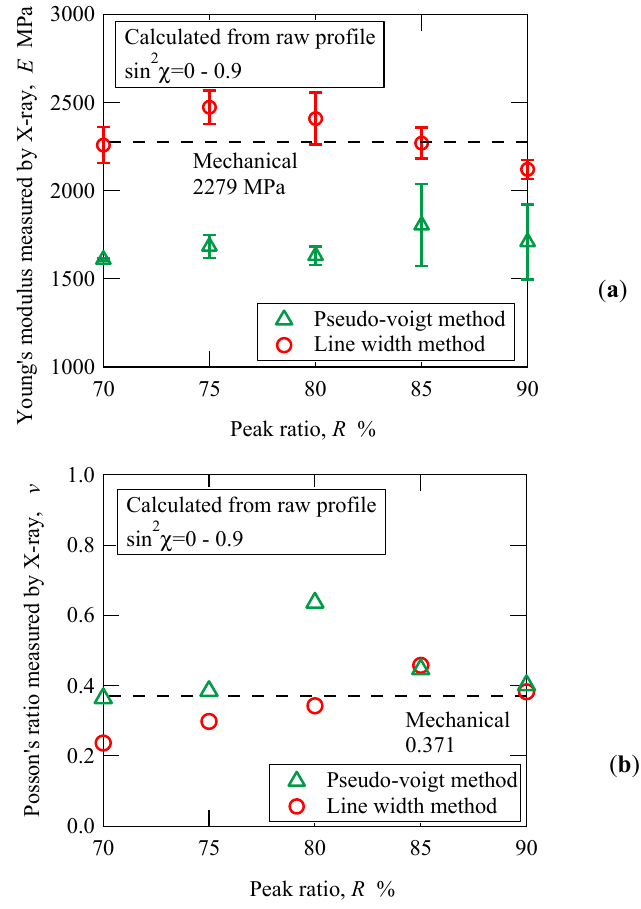
Figure 11. X-ray elastic constants: ( a ) Young’s modulus; ( b ) Poisson’s ratio.